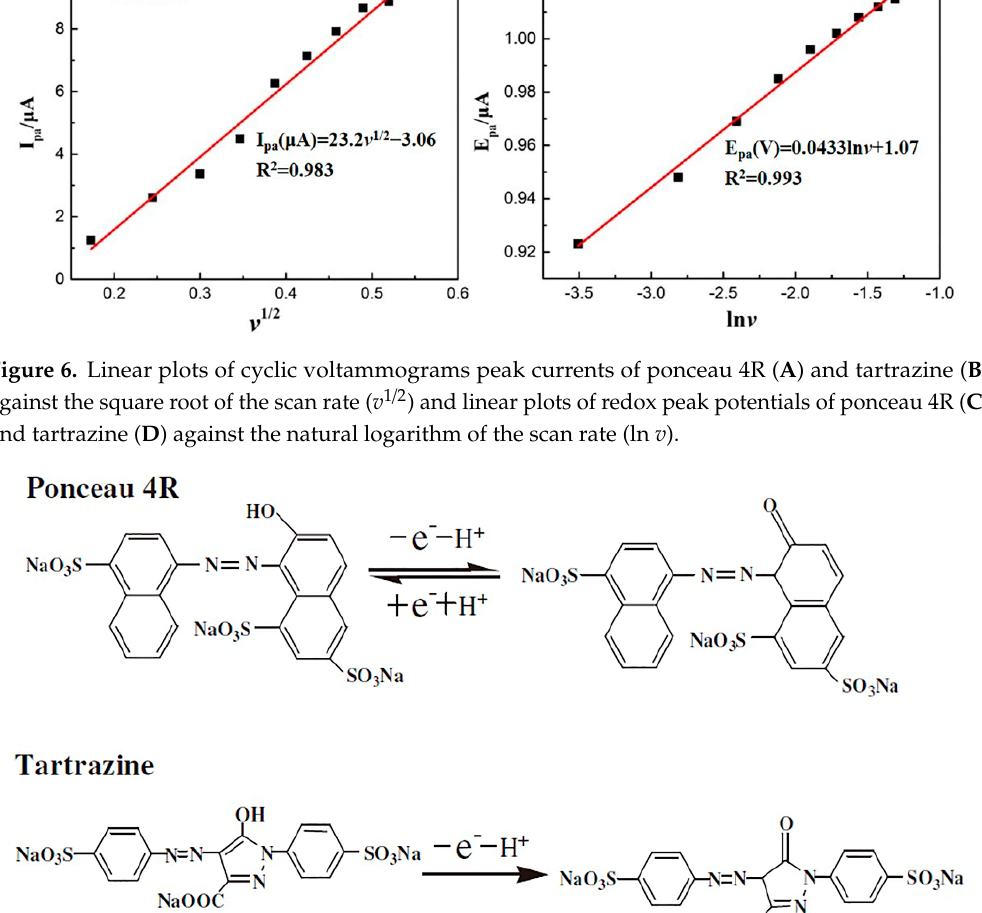
Figure 7. Electrooxidation mechanism of ponceau 4R and tartrazine at TiO 2 /ErGO/GCE.